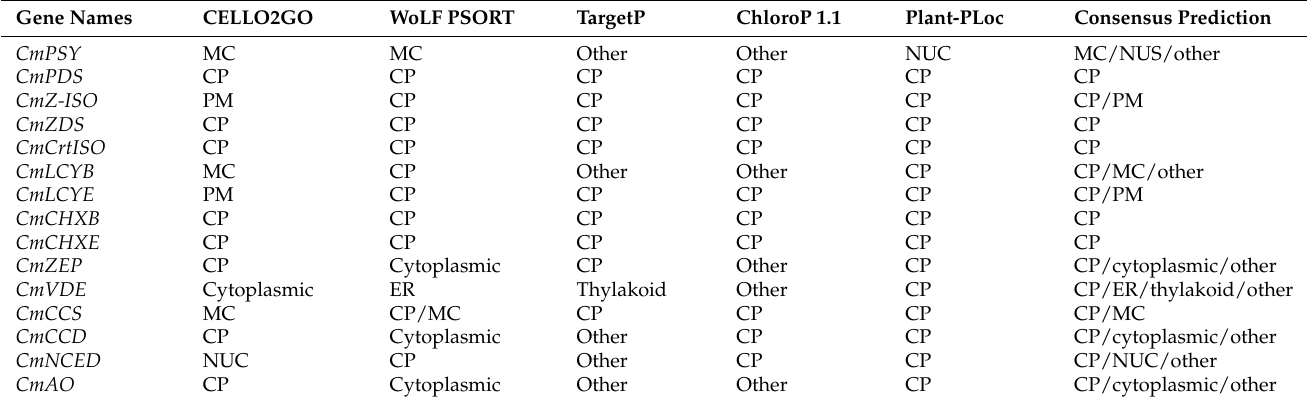
Table 3. The subcellular-localization predictions of C. majus CBP, XBP, and ABP